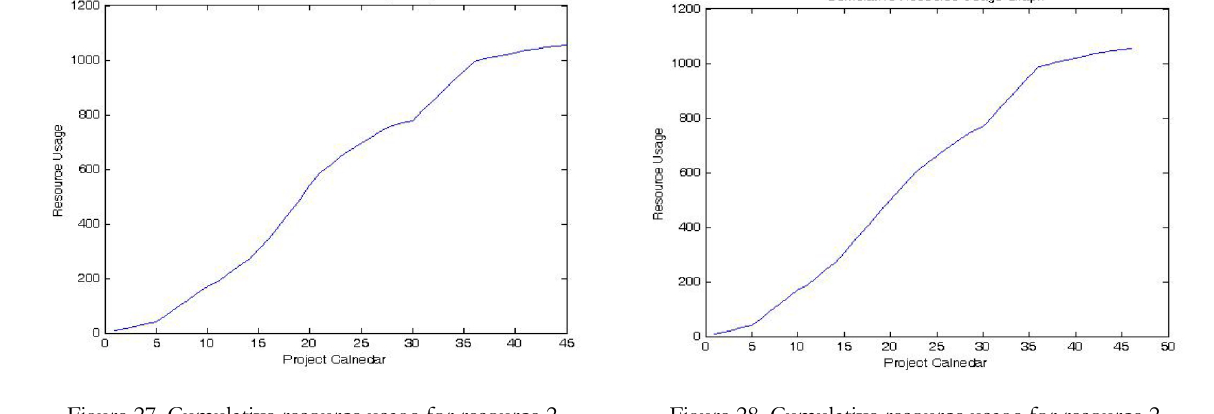
Figure 27. Cumulative resource usage for resource 2 of experiment 2 (relaxed resource constraint)